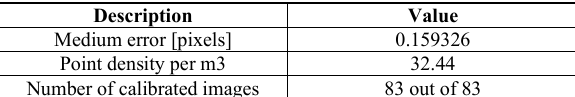
Table 3: Results values in case reconstruction case 2